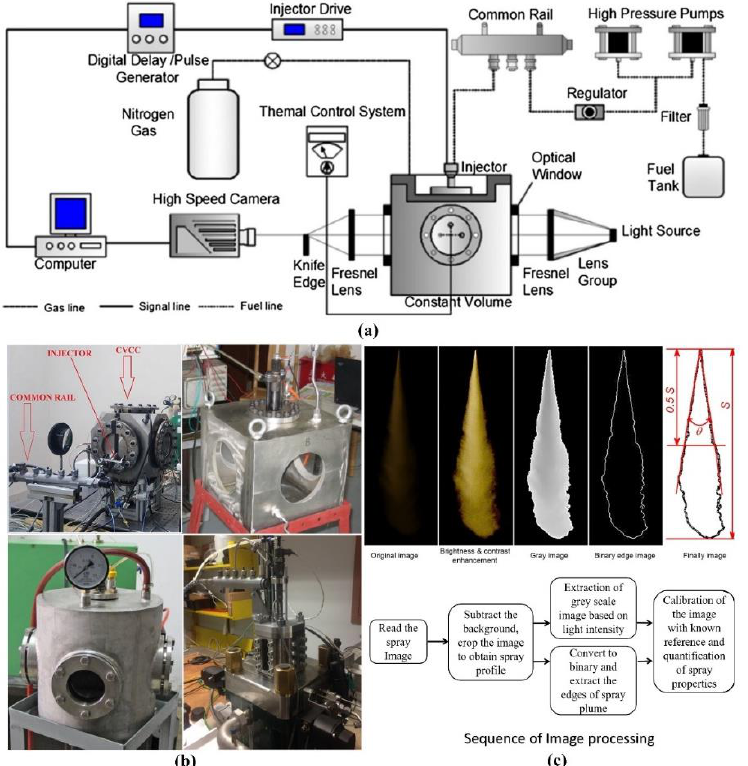
Figure 1. ( a ) Schematic of a spray analysis setup. Reprinted with permission from Ref. [19]; ( b ) Control volume vessels used for fuel spray analysis with optical windows for visualization. Reprinted with permission from Refs. [27–29]; ( c ) Sequence for image processing and their results. Reprinted with permission from Ref. [30].